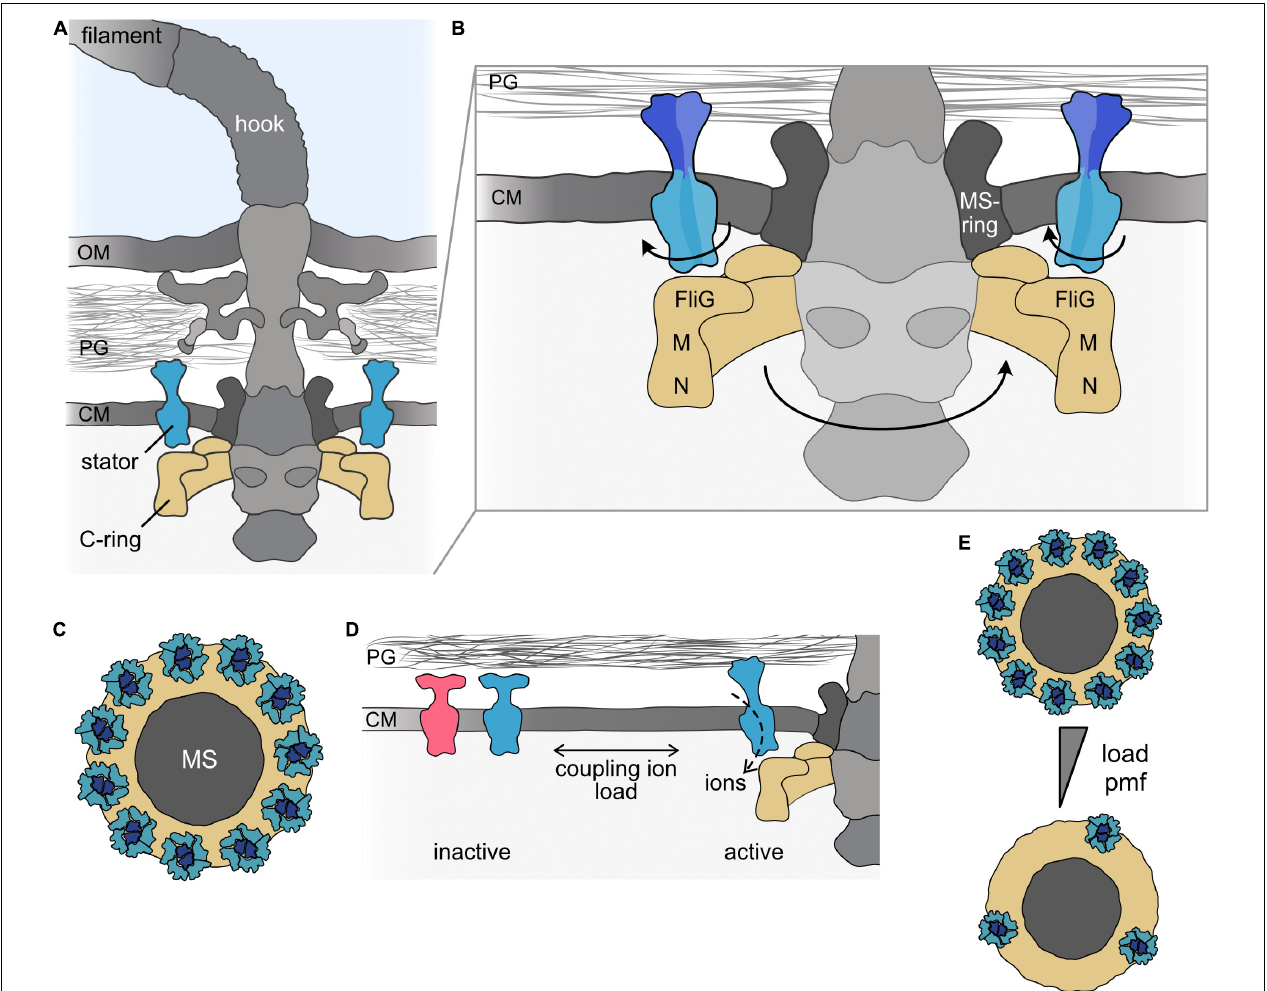
FIGURE 1 | The bacterial flagellar motor. (A) Cartoon of the bacterial flagellum of a Gram-negative bacterial cell. The flagellum consists of the long helical filament and the universal joint, the hook, which connects the filament and the flagellar motor. The motor is part of the basal body, which firmly anchors the flagellar apparatus in the cell envelope and, in addition, houses a type III–like protein export system. The main flagellar components involved in torque generation, the rotary C-ring and the stators, are shown in the same colors (here and throughout all figures). (B) Magnification of the flagellar motor. In the rotating motor, the ion-conducting stators (here blue) are anchored to the cell wall by a peptidoglycan-binding domain at the C-terminus of the B subunit of the stator. The ion flow leads to rotation of the A-subunits of the stator around the centered B-subunits. The rotation is transferred to the flagellar rotor, the C-ring (depicted in yellow), which consists of multiple copies of the proteins FliG, FliM, and FliN. Rotation of the C-ring is induced by electrostatic interaction of the A-subunits of the stator with FliG. (C) Top view on the transmembrane MS-ring (dark gray) to which the C-ring (yellow) is mounted. The stator units are positioned around the MS-ring above the C-ring. In a fully assembled motor of E. coli , about 11 stators are engaged with the rotor. (D) Stator units are produced as inactive precomplexes, which diffuse in the membrane. Upon engaging with the motor, the stators bind to the peptidoglycan and the ion channel opens. Stator units can also leave the motor to re-join the pool of inactive stator units in the cytoplasmic membrane. The equilibrium is affected by environmental signals, e.g., the concentration of the coupling ion and/or the load acting on the flagellar filament. Stator coupling and uncoupling occurs while the flagellum continues to rotate. Notably, more than one stator type can be present (indicated by the blue and red colors). (E) Under conditions of low load or at a low concentration of the coupling ion, only a few stators are engaged with the motor. A single stator is generally sufficient to drive flagellar rotation under conditions of low load. Under conditions of increasing load and/or increasing concentration of the coupling ion (indicated by the gray triangle), the maximal number of stators can be engaged. OM, outer membrane; PG, peptidoglycan; CM, cytoplasmic membrane; M, FliM; N, FliN; MS,